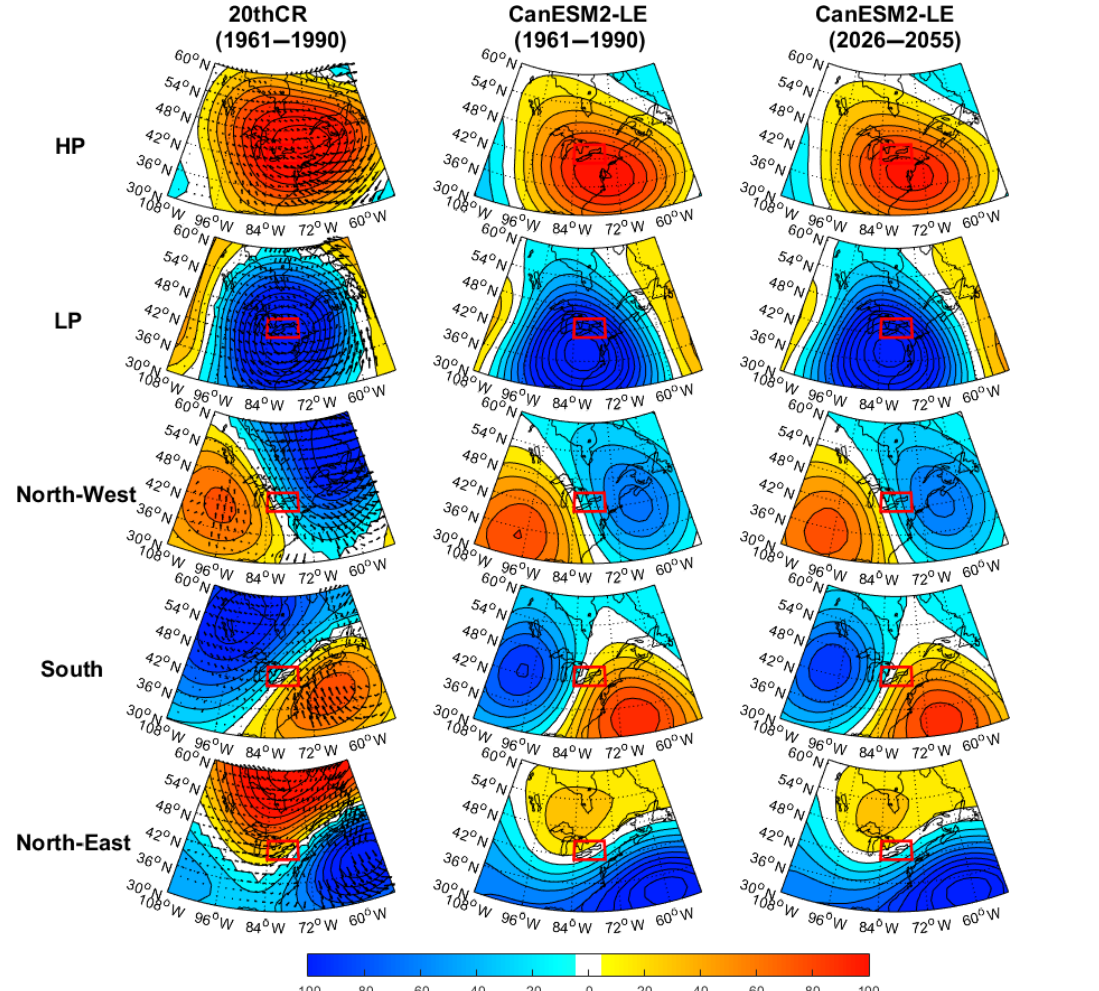
Figure 3. Left panels: DJF Z 500 anomalies (colours) and winds (vectors) corresponding to weather regimes calculated with 20thCR in the 1961–1990 period. Middle panels: DJF 50-member average Z 500 anomalies calculated with CanESM2-LE in the 1961–1990 period. Right panels: DJF 50-member average Z 500 anomalies calculated with CanESM2-LE in the 2026–2055